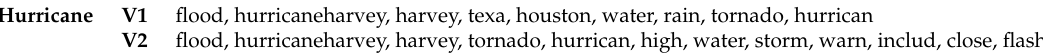
Table 6. Final set of seed words for the variants V1 (union vocabulary) and V2 (difference vocabulary) for the hurricane dataset (bottom). The number of seed words can differ as the biterms from Table 5 are split